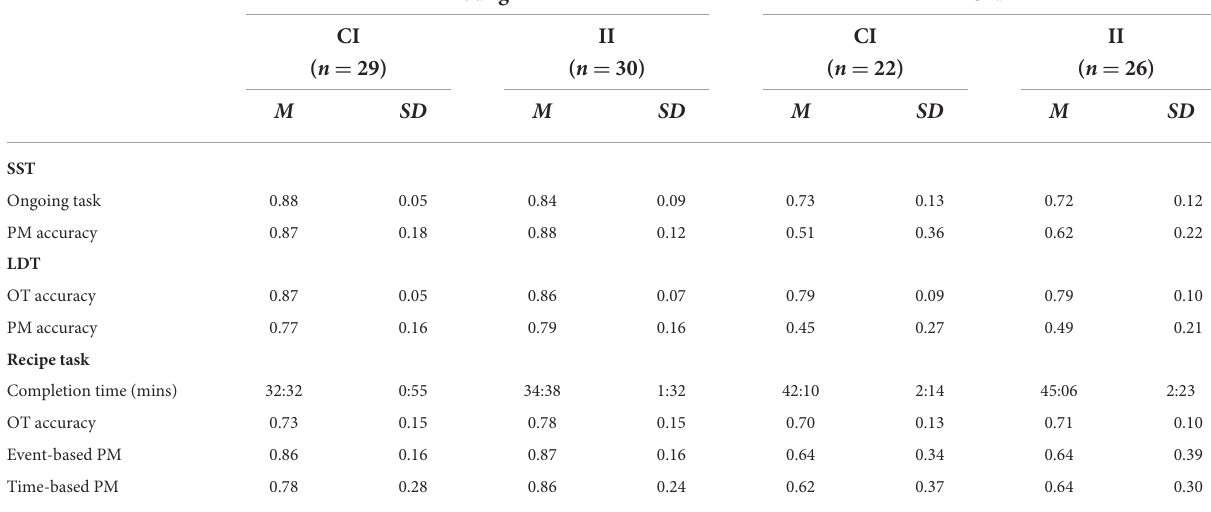
TABLE 2 Proportion of correct responses (%) on PM tasks and ongoing tasks and completion